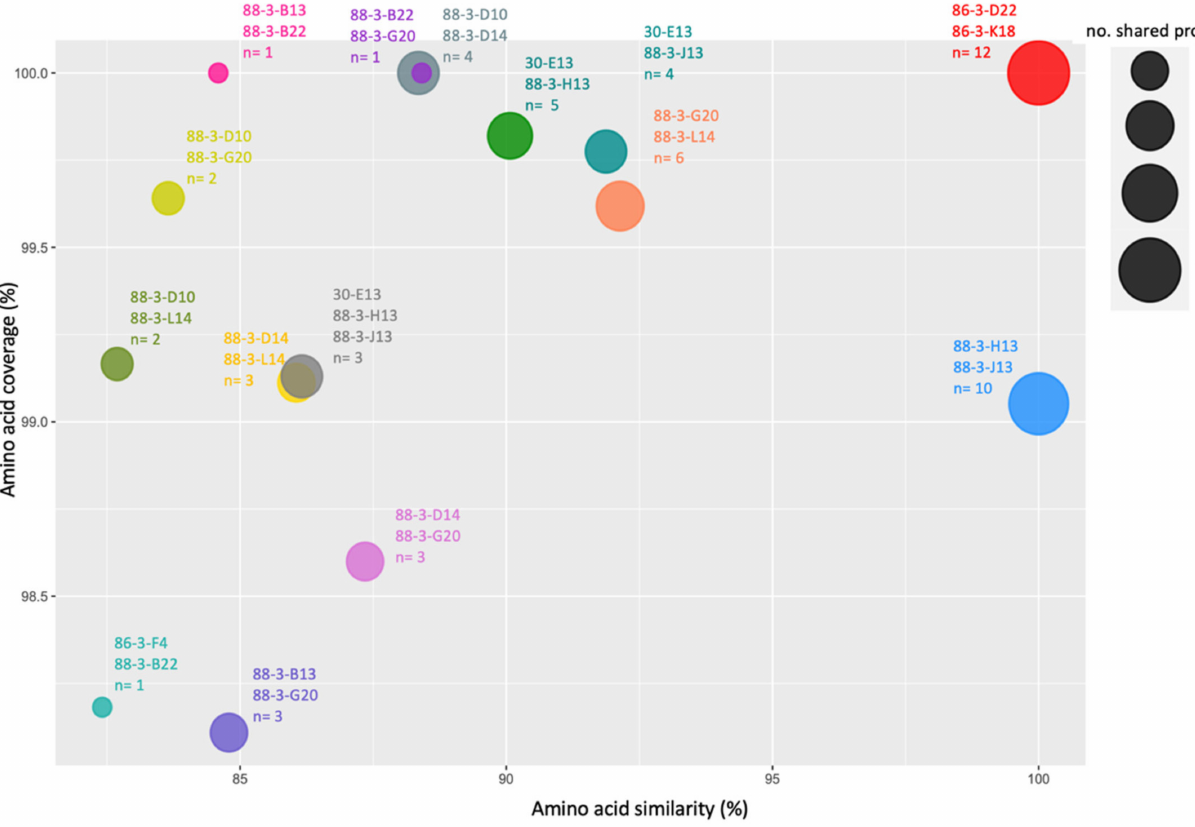
Figure 3. Shared proteins between vSAGs. Each circle represents two (or three) vSAGs sharing at least one protein. The area of the circle is related with the number of shared